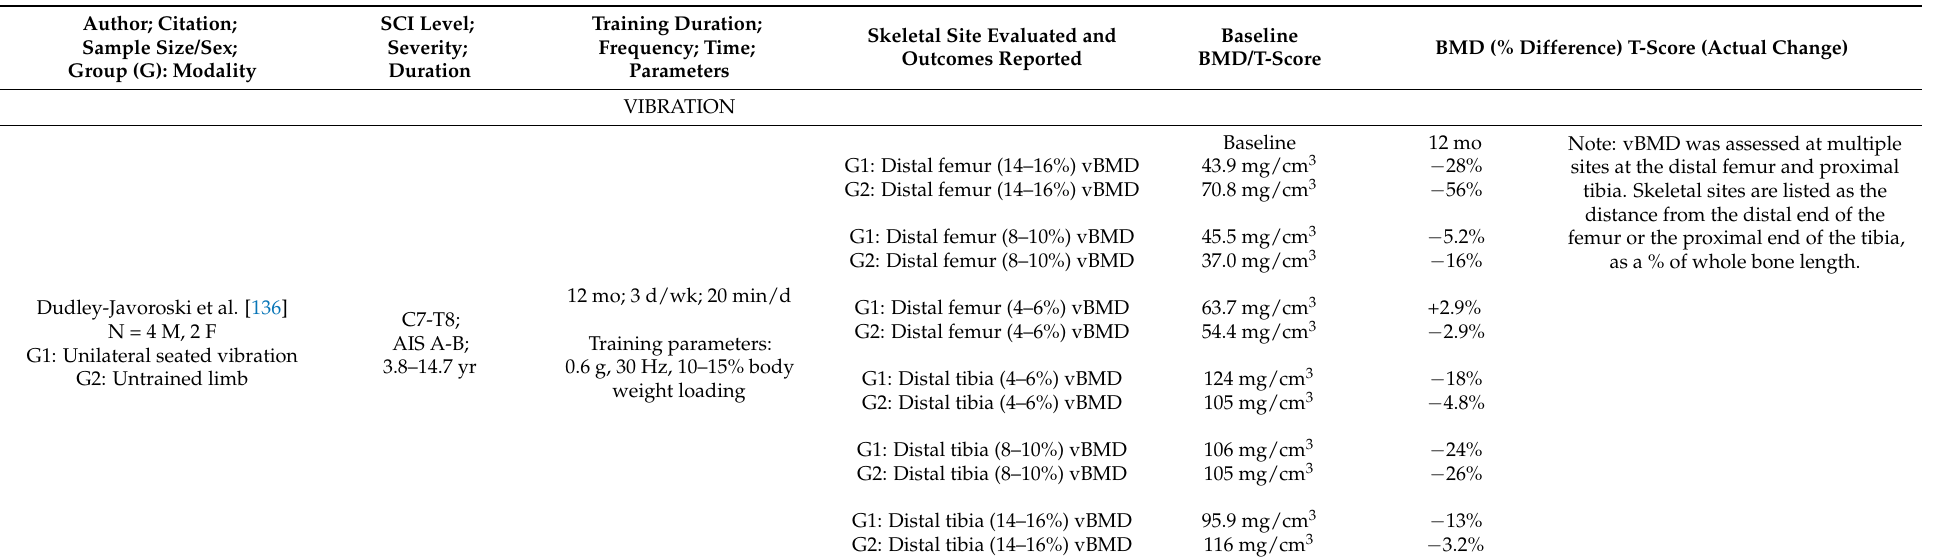
Table 5. Controlled interventional studies evaluating the effects of activity-based physical therapy (ABPT) and/or loading on bone mineral density (BMD) or T-scores in adults with chronic spinal cord injury